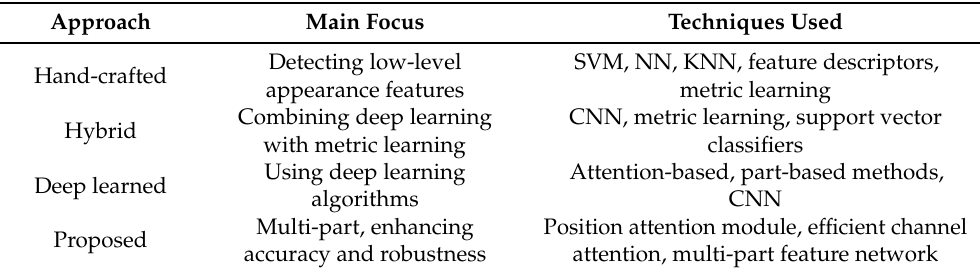
Table 1. Summary of the main differences between the proposed work and related work.